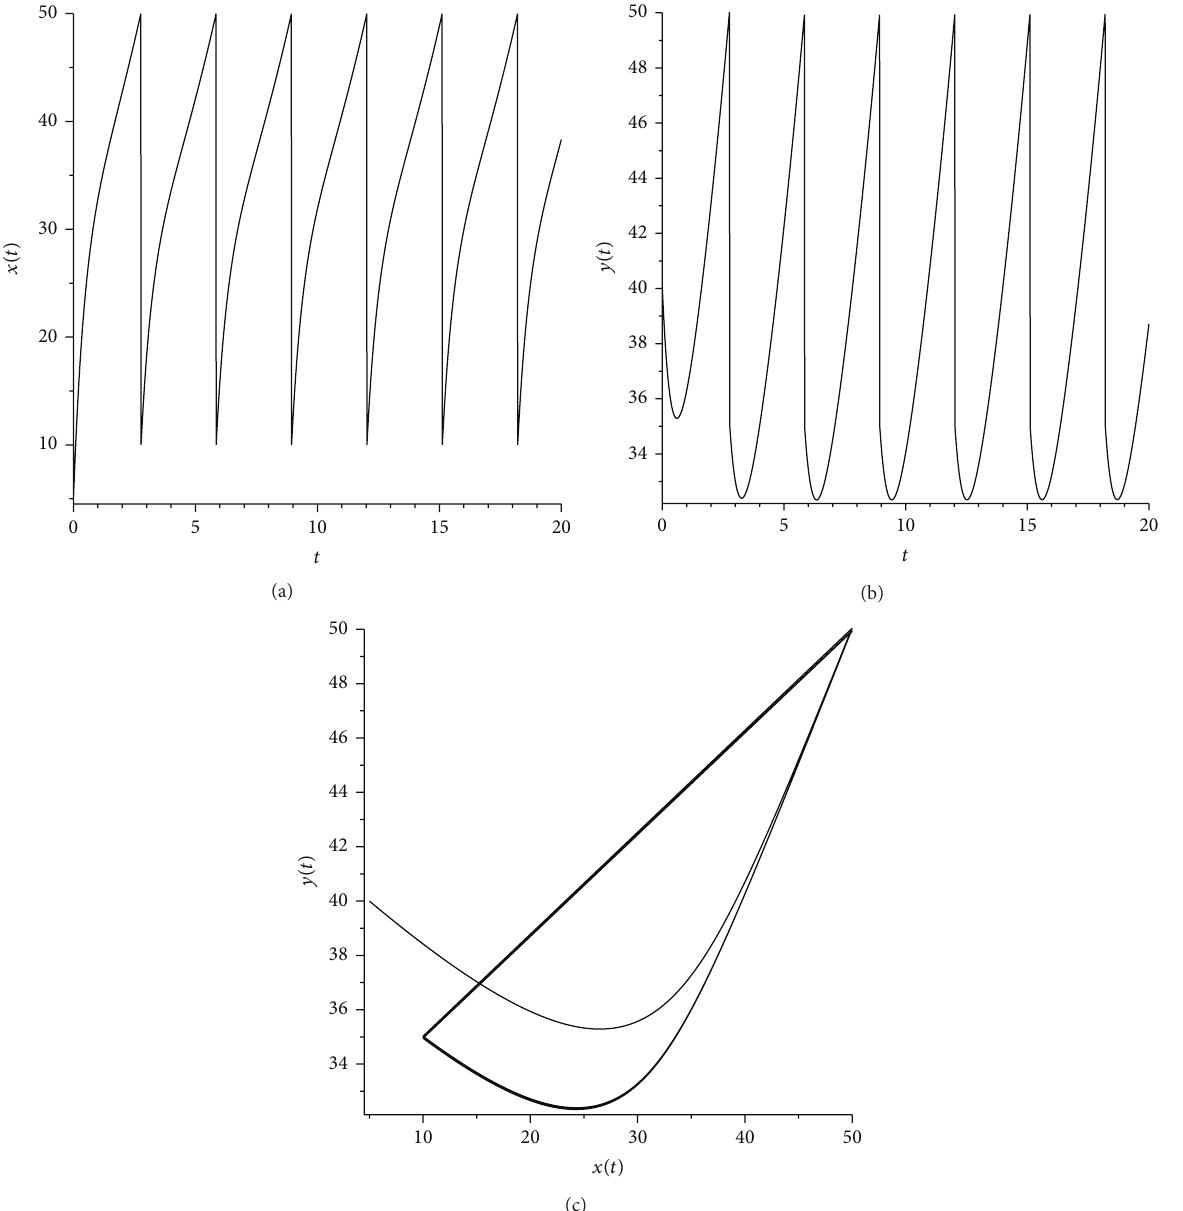
Figure 13: Time series and phase portrait of system (1) with 𝑎 = 1 . 7 ,𝑏 = 1 . 5 , 𝑐 = 0 . 8 , 𝑑 = 0 . 6 ,𝑥 ∗ = 50 ,𝛼 = 0 . 8 , 𝛽 = 0 . 3 ,(𝑥 0 ,𝑦 0 ) = ( 5 , 40 )